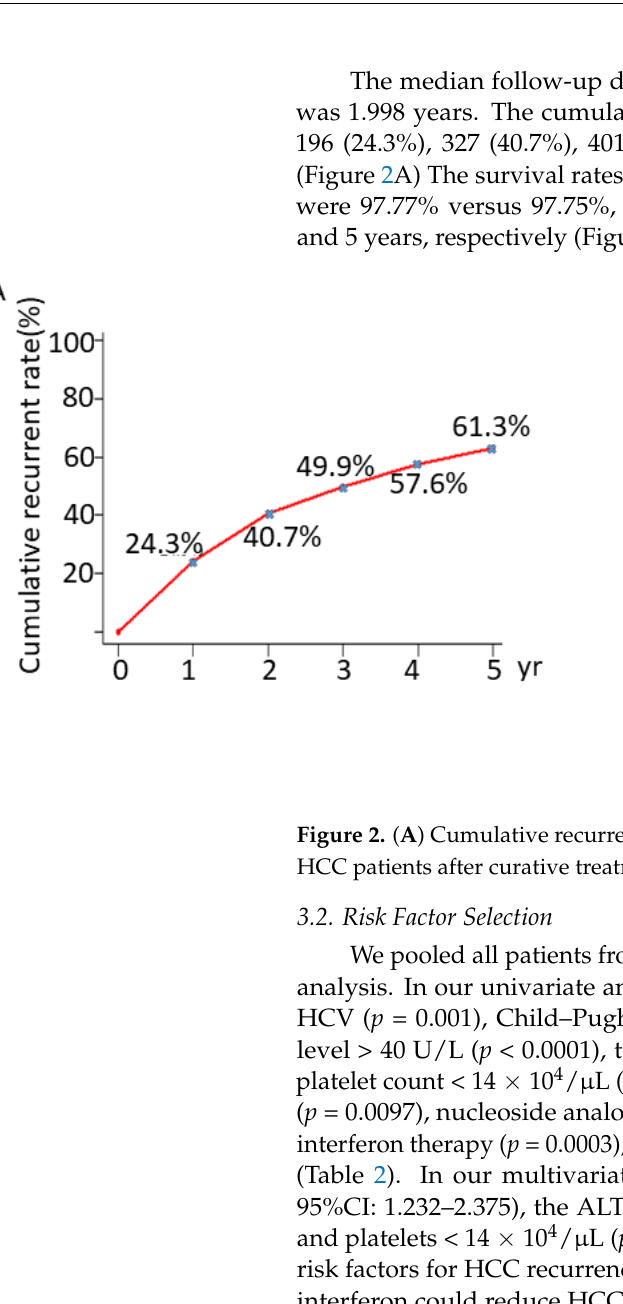
(Table 2). In our multivariate analysis, alcohol drinking habits ( p = 0.001, HR: 1.711,